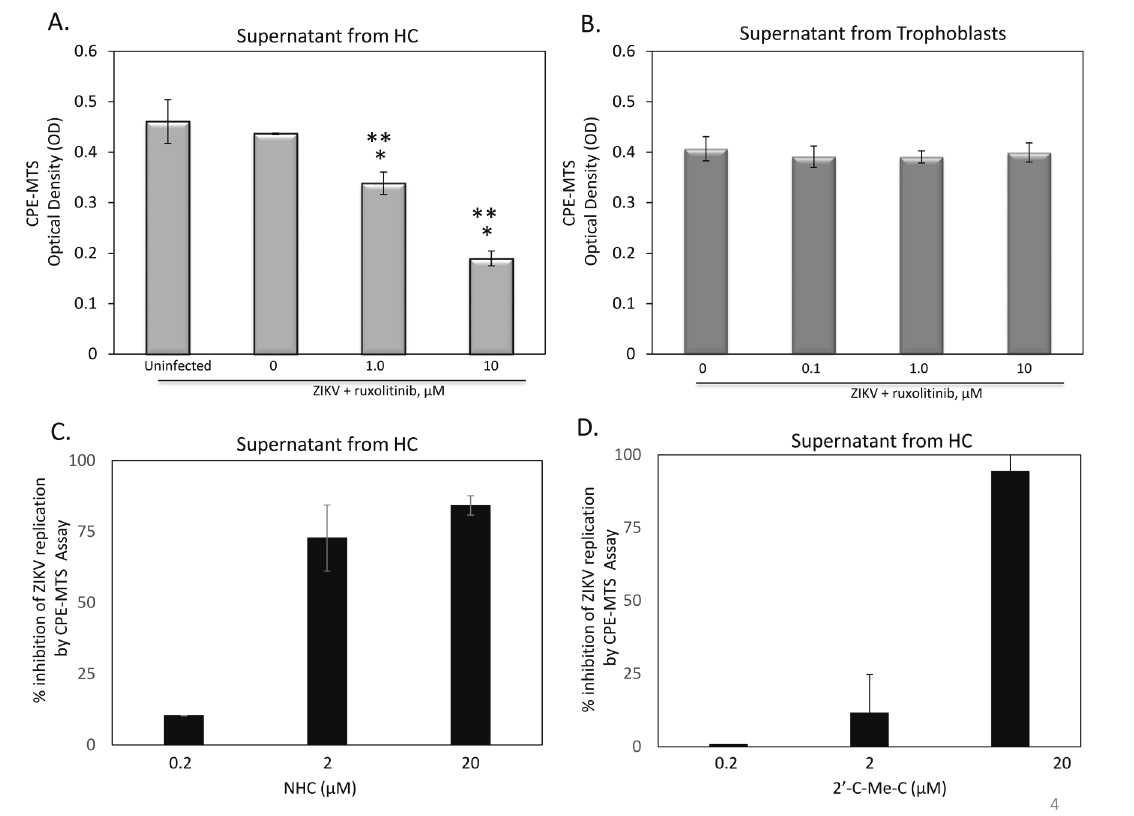
Figure 3: Effect of ruxolitinib on ability of HC or trophoblast supernatants infected with ZIKV PRV- ABC59 to confer virally induced CPE in Vero cells. Primary HC or trophoblasts were infected with MOI 1 of ZIKV PRVABC59 to induce viral production. Cell death (cytopathic effect; CPE) induced by the viral supernatants were quantified with an MTS assay. Supernatants from HC infected with PRVABC59 did not confer virally induced CPE (A), whereas addition of 1 and 10 µM in HC cultures demonstrated a dose dependent increase in virally induced CPE in Vero cells (A). Supernatants from trophoblasts, either in the absence or presence of ruxolitinib did not confer virally induced CPE in Vero cells (B). Antiviral agents β-D-N4-hydroxycytidine (NHC) and 2'-C-methyl-cytidine (2'-Me-C) added in various concentrations to HC or trophoblast cultures also maintained with 1 µM ruxolitinib during ZIKV infections demonstrated a dose dependent protection from virally induced CPE for HC supernatants transferred to Vero cells (C, D). Supernatants for trophoblasts, in contrast, did not confer virally induced CPE for any conditions, therefore effect of antiviral agents could not be measured (data not shown). * demonstrates significant difference versus infections in the absence of ruxolitinib; ** demonstrates significant difference versus uninfected controls ( P < 0.05, One Way